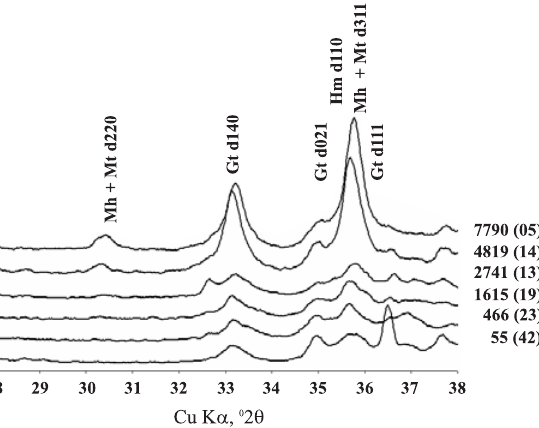
Figura 6. Difratograma de raios X de seis amostras (pontos de amostragem entre parênteses), com valores crescentes de χχχχχ (10 -8 m 3 kg -1 ) (Mh + Mt: BF maghemita + magnetita; Gt: goethita;